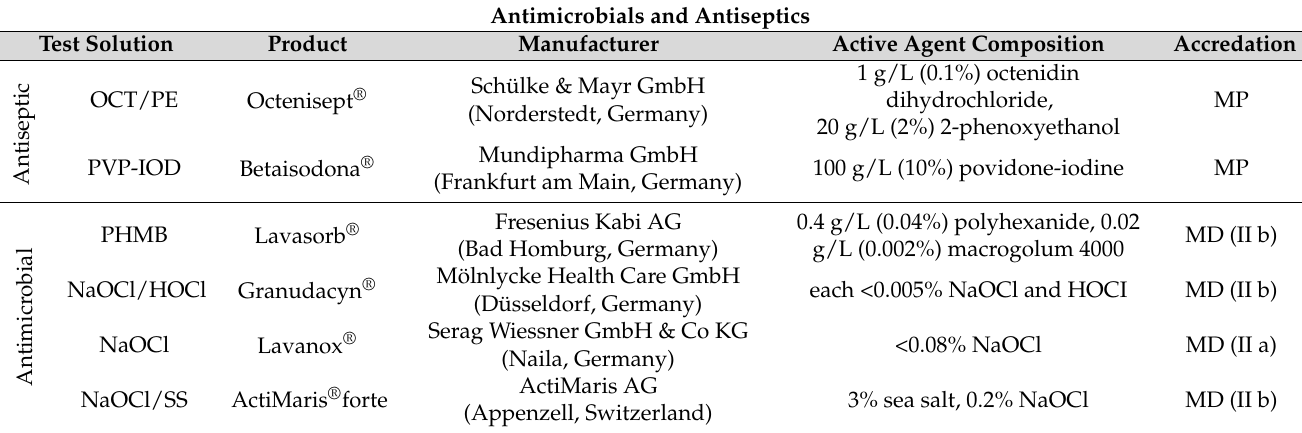
Table 1. Overview of investigated antimicrobials and antiseptics. Substances are categorized in antiseptics and antimicrobials based on common consent and manufacturer specifications. Test solution, product name, manufacturer, active agent composition, and known accreditation are stated (MP: Medical product; MD: Medical device). Antimicrobials and